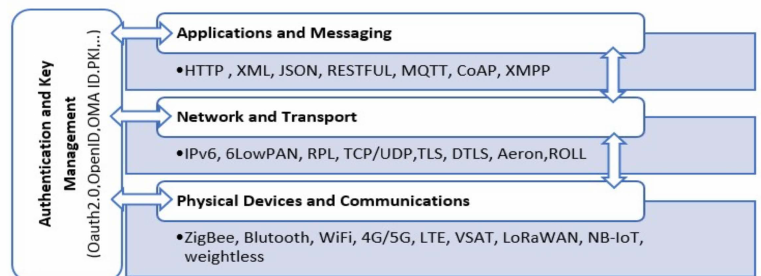
Figure 2. The protocols and standards of